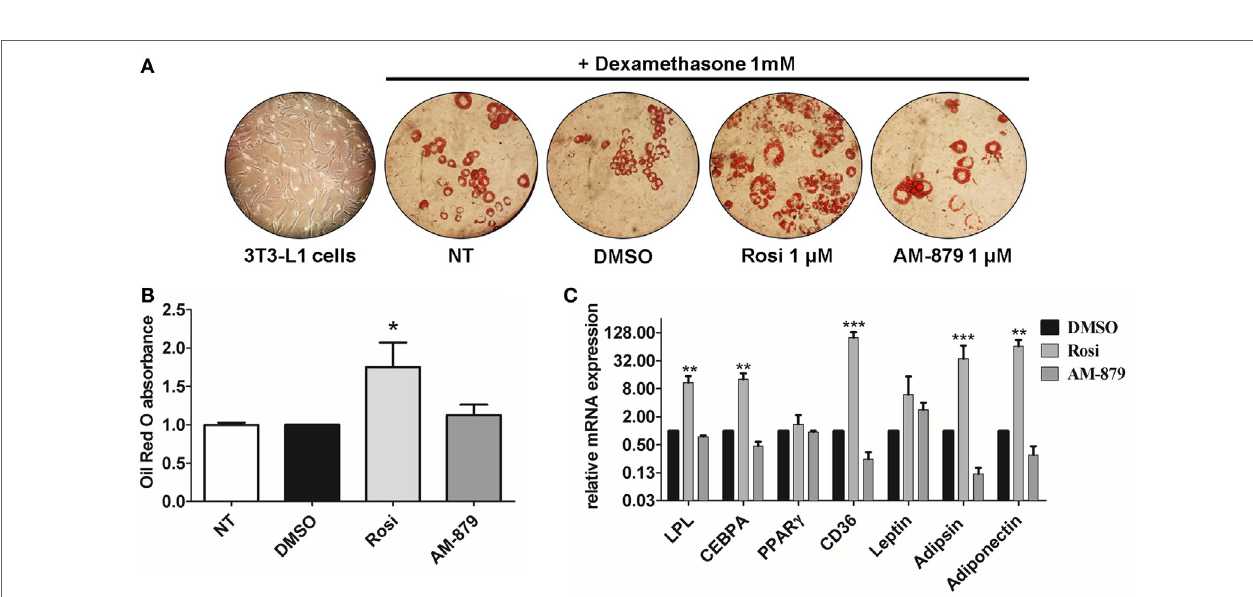
FigUre 5 | Effects of AM-879 on adipocyte differentiation and gene expression. (a) Representative images (400 × ) of lipid accumulation by Oil Red O staining in 3T3-L1 differentiated cells under different conditions. Images were obtained in random fields of three independent experiments performed in duplicates. (B) Quantification of lipid accumulation by Oil Red O absorbance measurement at 520 nm in not-treated 3T3-L1 differentiation cells, or in cells treated with dimethyl sulfoxide (DMSO) (control, 5%), Rosiglitazone (Rosi, 1 µM), or AM-879 (1 µM). Data were normalized by DMSO absorbance. (c) RT-qPCR analysis of LPL , CEBPA , PPAR γ , CD36 , Leptin , Adipsin , and Adiponectin expression levels in differentiated 3T3-L1 cells treated with 1 µM Rosi, 1 µM AM-879, or 1% DMSO (control). Data are the mean ± SEM ( n = 3 independent replicates, * p < 0.05, ** p < 0.01, *** p < 0.001 vs DMSO).